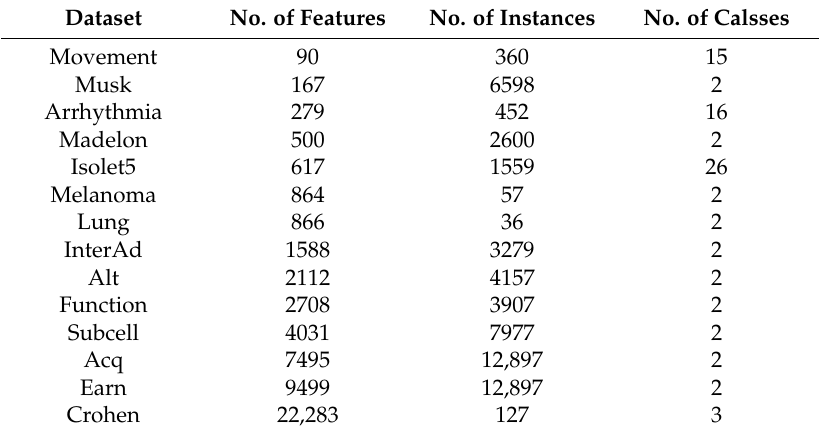
Table 1. Dataset